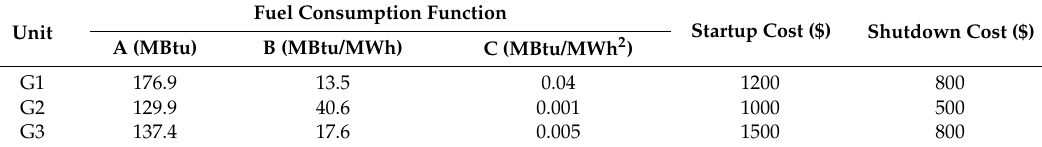
Table 4. Thermal generator energy data.